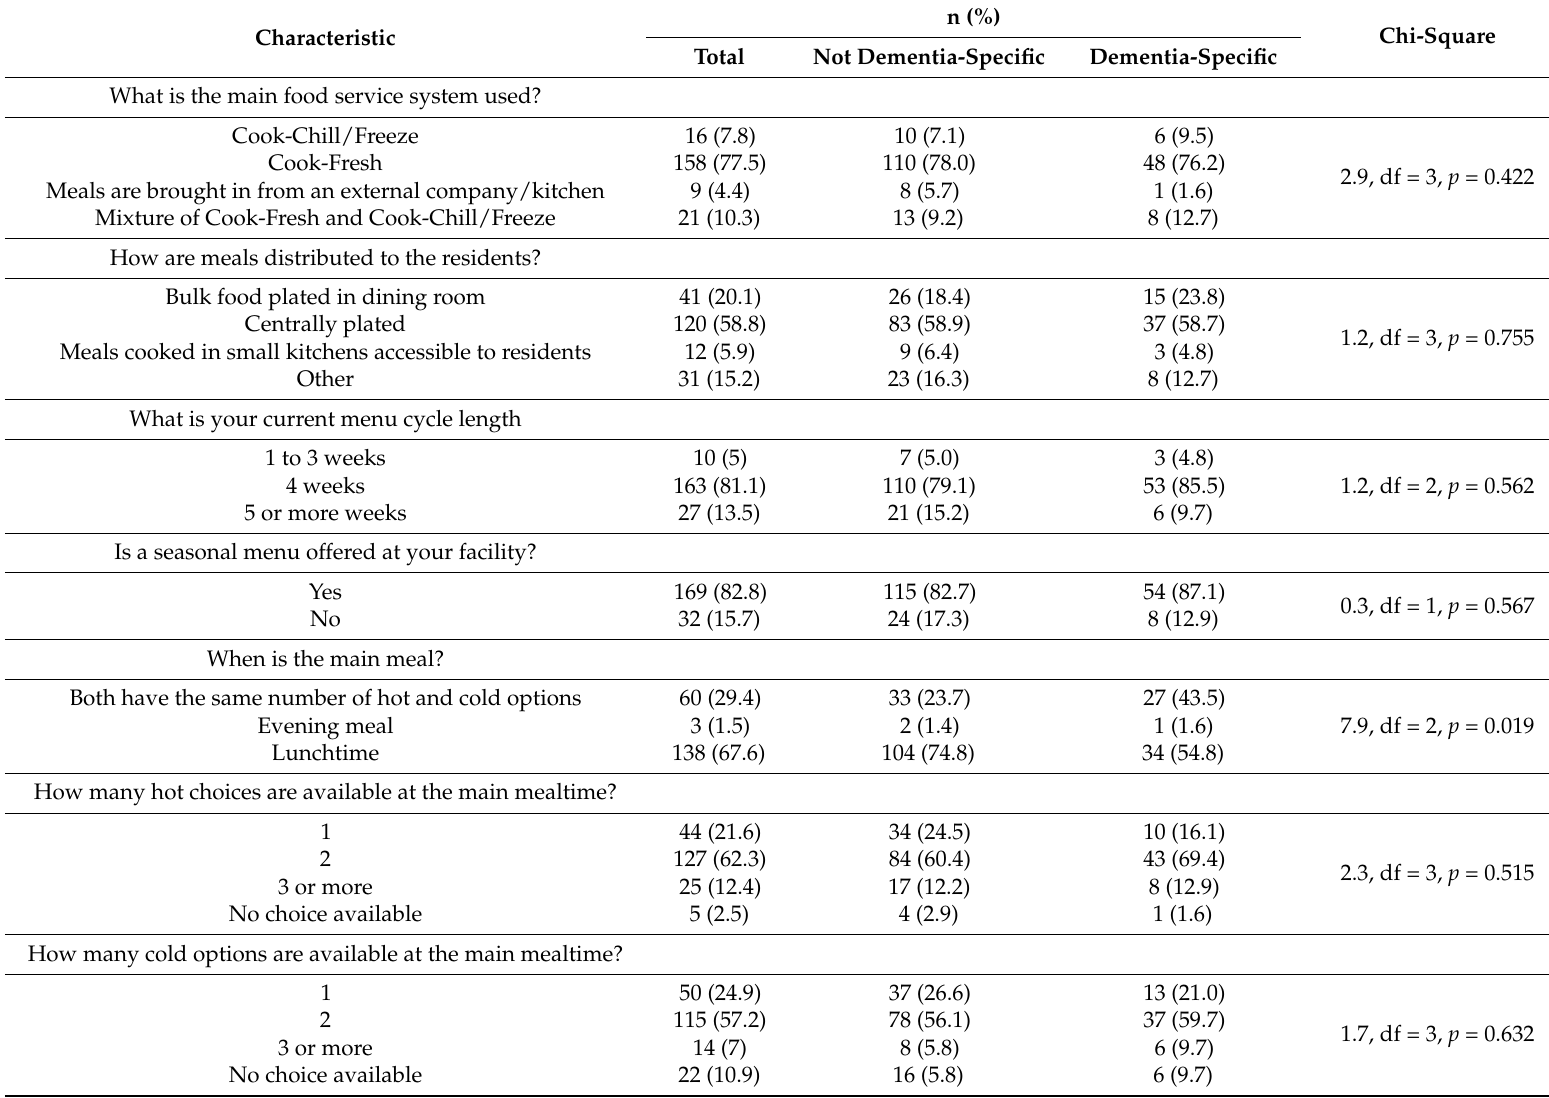
Table 2. Food service characteristics of responding